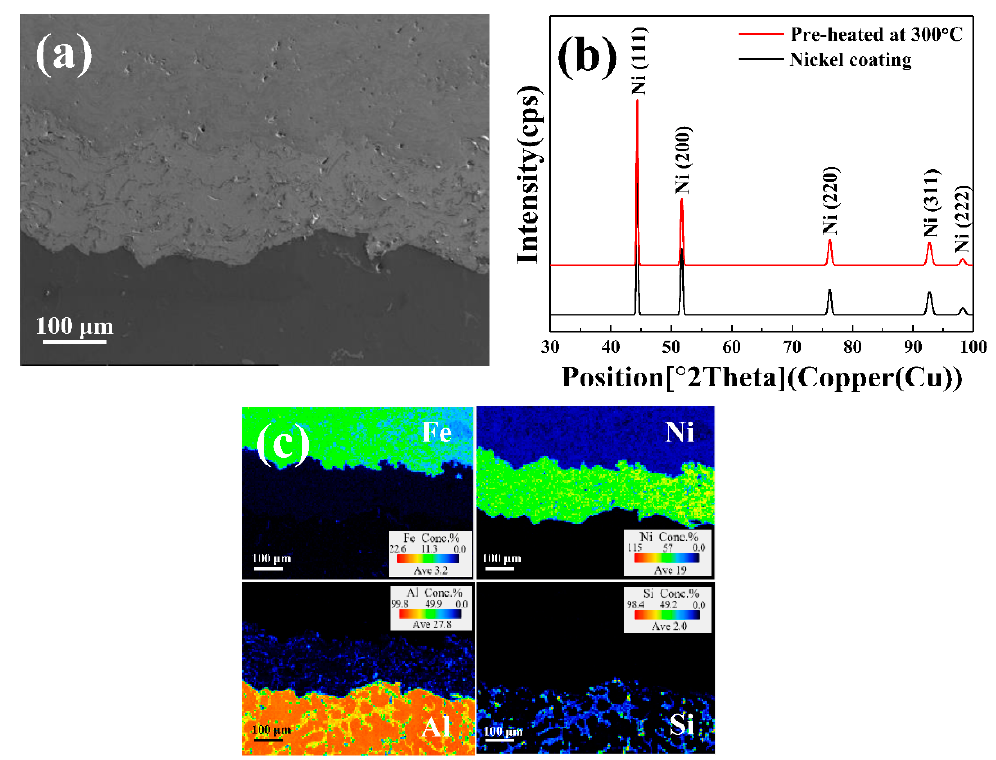
Figure 1. ( a ) SEM micrographs of the Al/Fe alloys hybrid structure’s interface with nickel coating; ( b ) XRD patterns of nickel coated steel before and after heat treatment at 300°C; ( c ) chemical element quantitative maps of ( a ): Fe, Ni, Al, and Si.